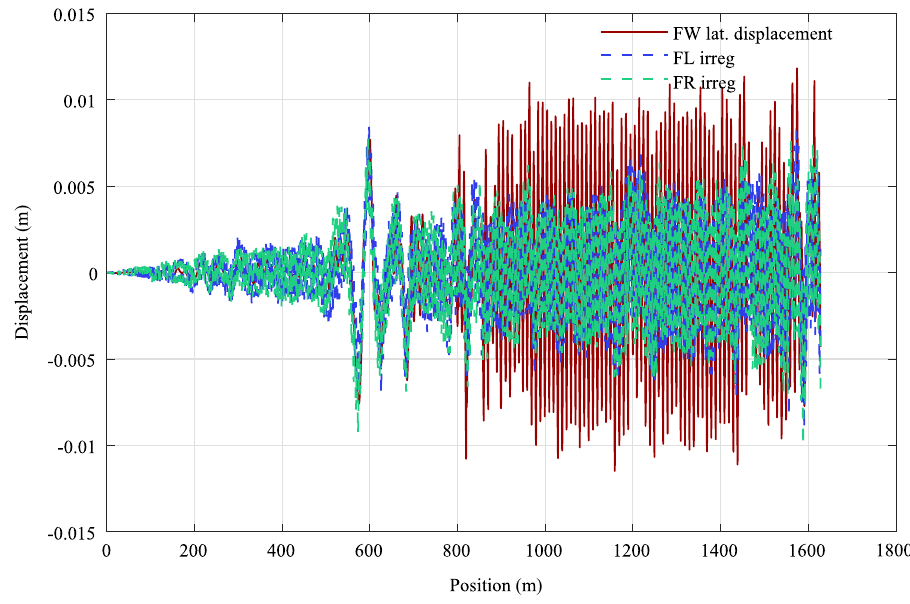
Fig. 9 Simulation with gauge variations with 5 mm amplitude and 5 m wavelength. The red line shows the lateral displacement of the front wheelset, and the blue and green dashed lines show the lateral displacement of the left and right rail, respectively, at the position of the front wheelset